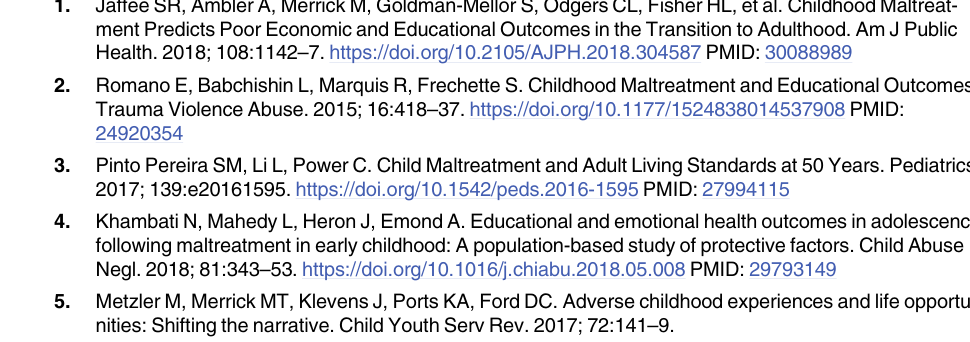
S10 Table. Estimated regression coefficients (for continuous outcomes) or AORs (for cate- gorical outcomes), 95% CIs, and p -values for the interaction between each ACE and mater- nal education. ACE, adverse childhood experience; AOR, adjusted odds ratio; CI, confidence